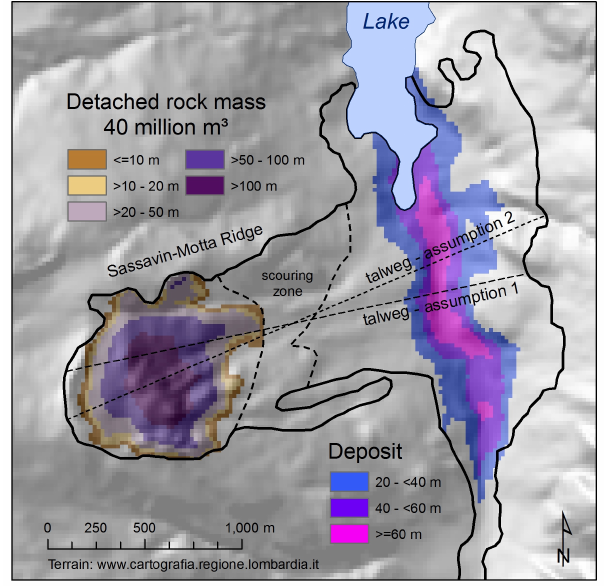
Fig. 4. Val Pola Rock Avalanche. Distribution of detached and deposited volumes as derived from the DEM change detection, the flow trimline was mapped from Landsat TM imagery (thick black